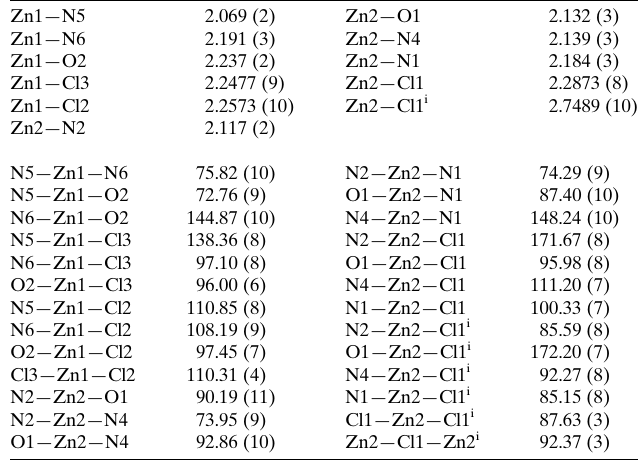
Table 1 Selected geometric parameters (A˚ , (cid:3) ).